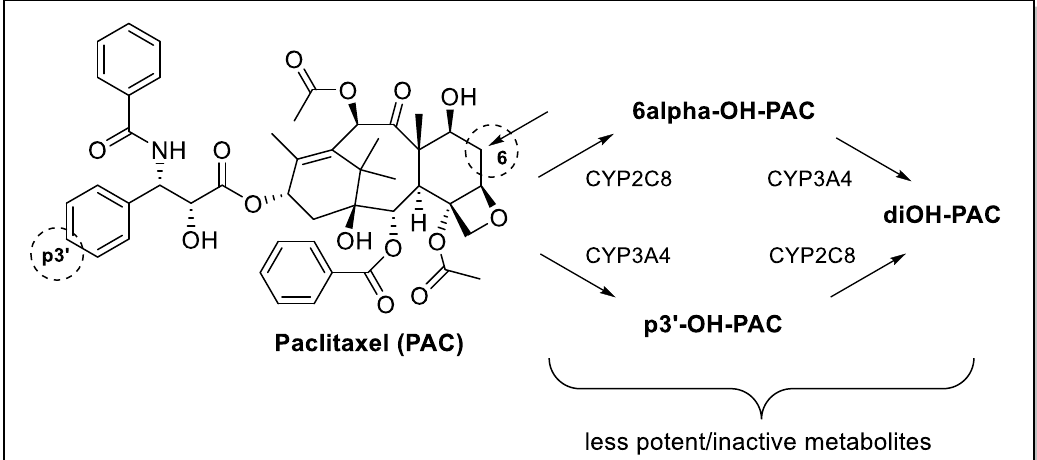
Figure 1. CYP metabolism contributes to paclitaxel treatment failure.